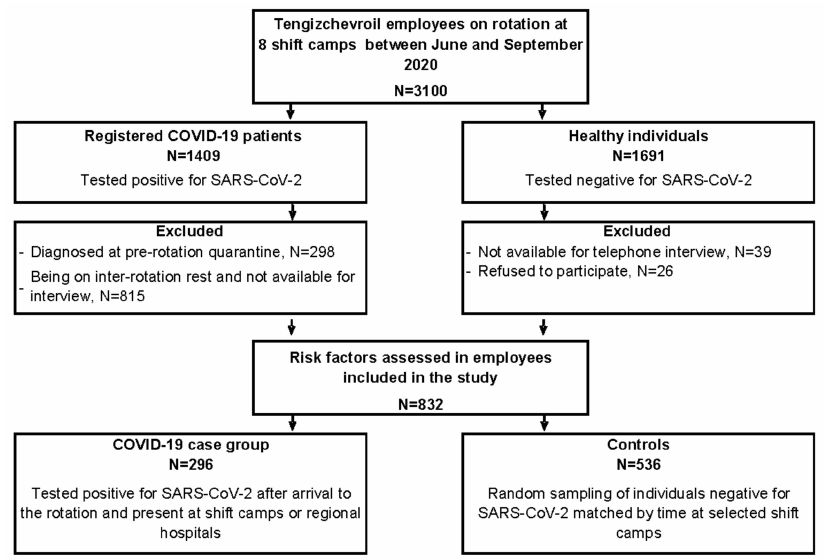
Figure 1. Flow chart of the participants included in the case-control study of factors associated with severe acute respiratory syndrome coronavirus 2 infection in Tengizchevroil, Kazakhstan